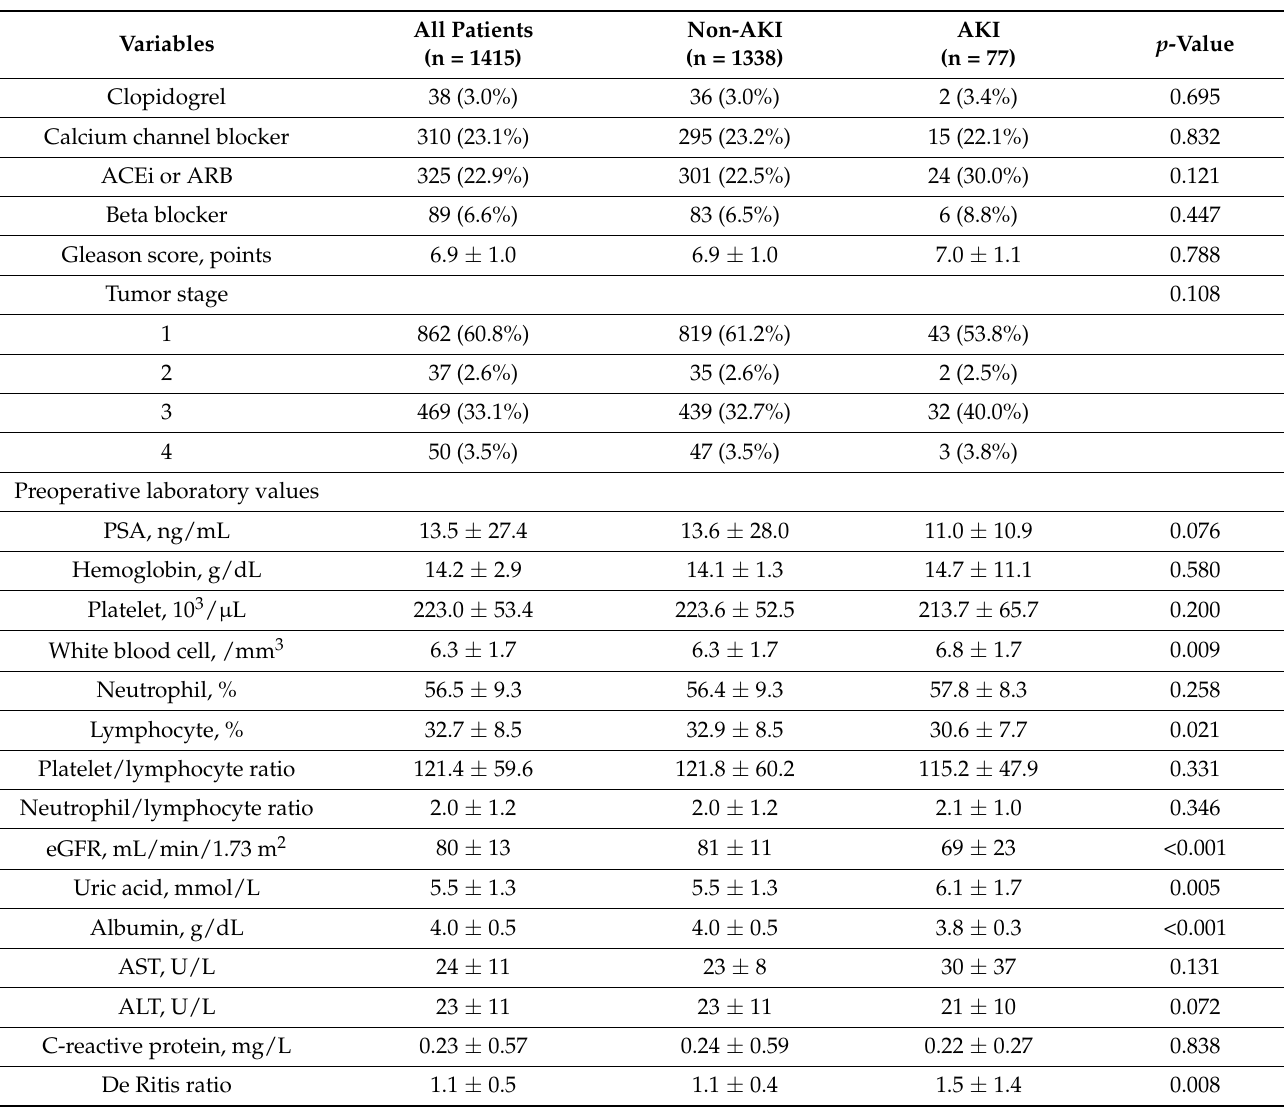
Table 3 shows that the factors related to AKI after RRP are age, white blood cell, eGFR, uric acid, albumin, red blood cell transfusion, and the De Ritis ratio at postoperative day 1 in the univariable logistic regression analysis. Multivariable logistic regression analysis found that eGFR, albumin level, and De Ritis ratio at postoperative 1 day are the significant independent risk factors for postoperative AKI (OR = 0.961, 95% confidence interval [CI] = 0.946–0.977, p < 0.001; OR = 0.249, 95% CI = 0.109–0.572, p = 0.001; OR = 7.353, 95% CI = 3.967–13.630, p < 0.001, respectively). All variance inflation factors were less